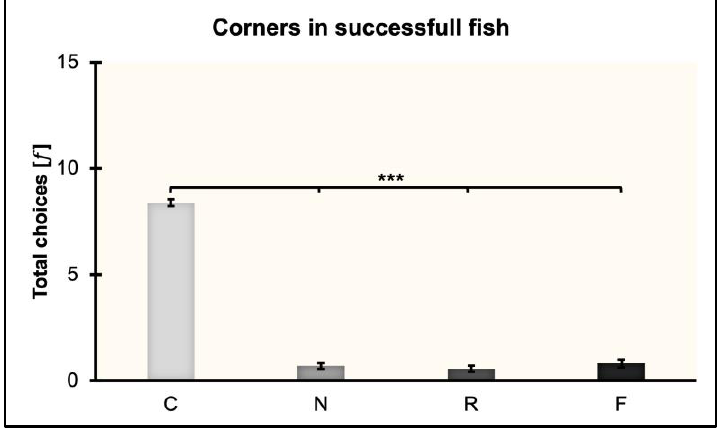
Figure 4. Total choices for the corners (geometry and landmark) in PS, PL, and DS collapsed. Mean ± SEM are shown. Significant p values are indicated with asterisks (*** p < 0.001).